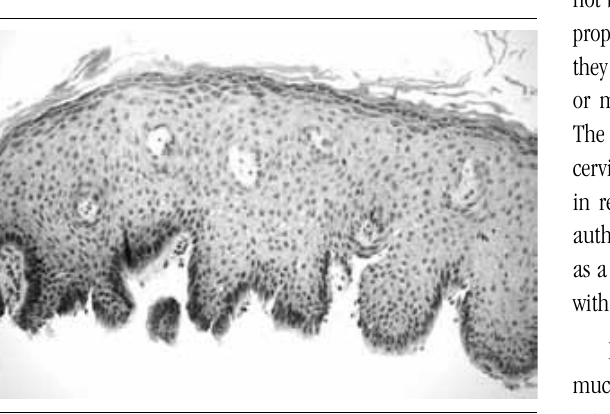
figurE 2 – Squamous mucosa of the uterine cervix with hyperpigmentation of basal layer cells without increase in melanocytes (HE, 100×) HE: hematoxylin and